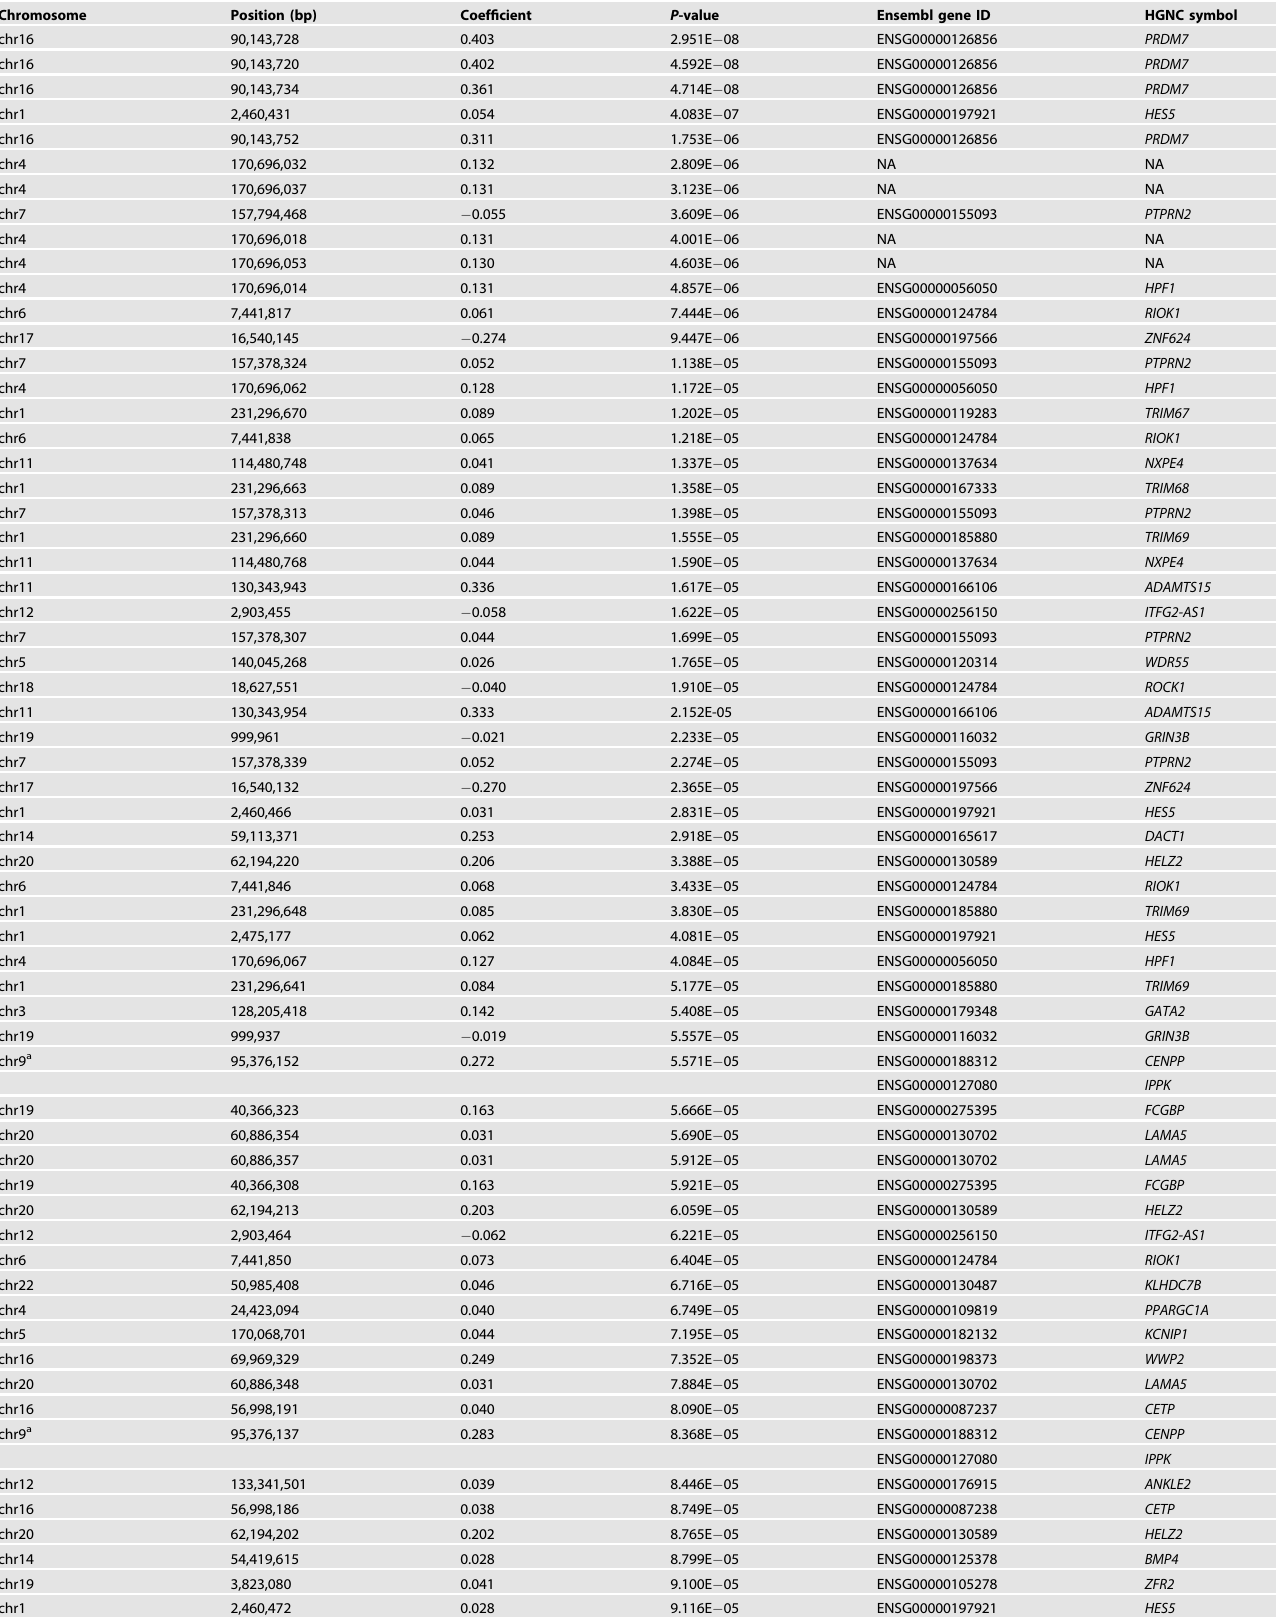
Table 2. The results of epigenome-wide association study on depression score ( P -value <1 × 10 − 4 ).